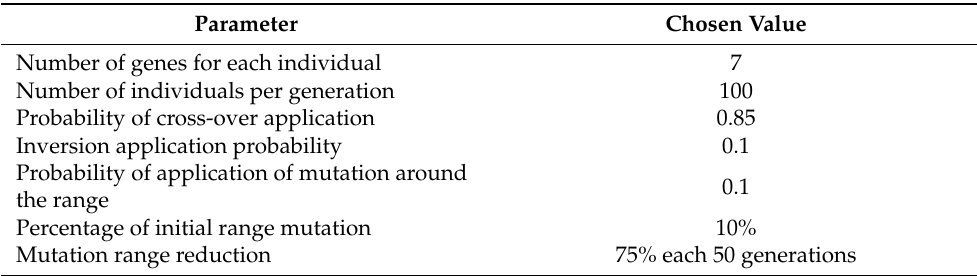
Table 2. Genetic algorithm intrinsic parameters’ chosen